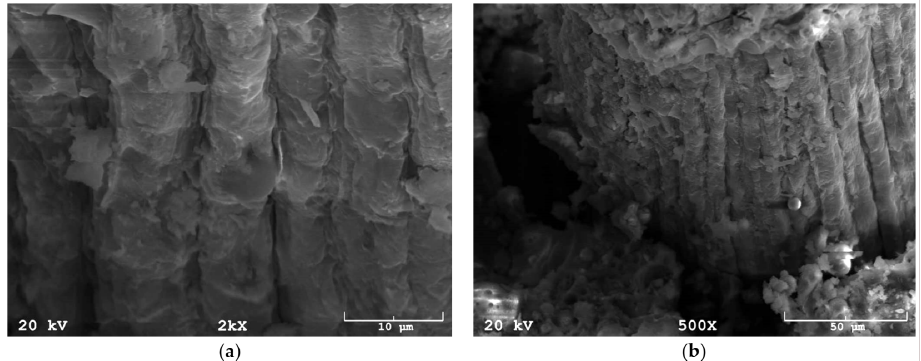
Figure 2. SEM image: ( a ) coir structure in a geopolymer matrix, ( b ) coherence of the fiber with the geopolymer matrix.